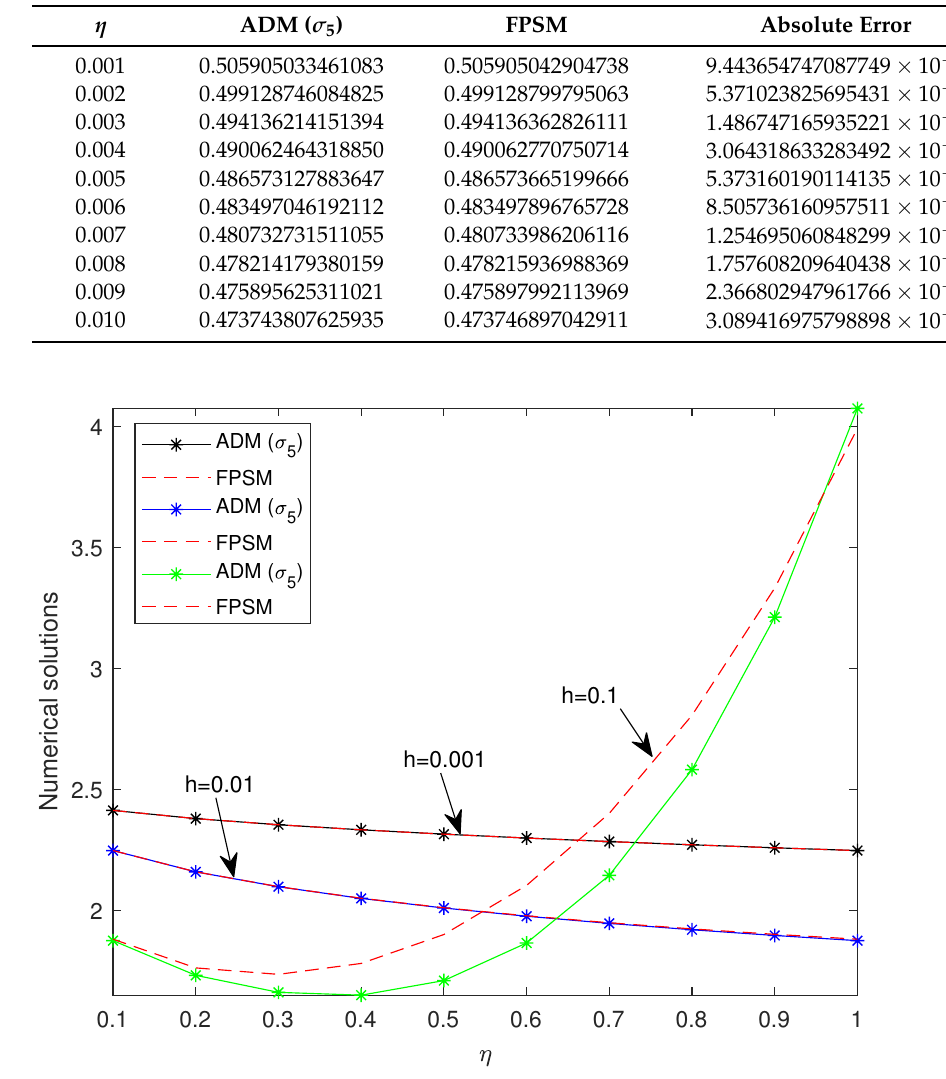
Figure 3. The ADM ( σ 5 ) and FPSM solutions of Equation (34), Υ ( η ) vs η , for h = { 0.1,0.01,0.001 }